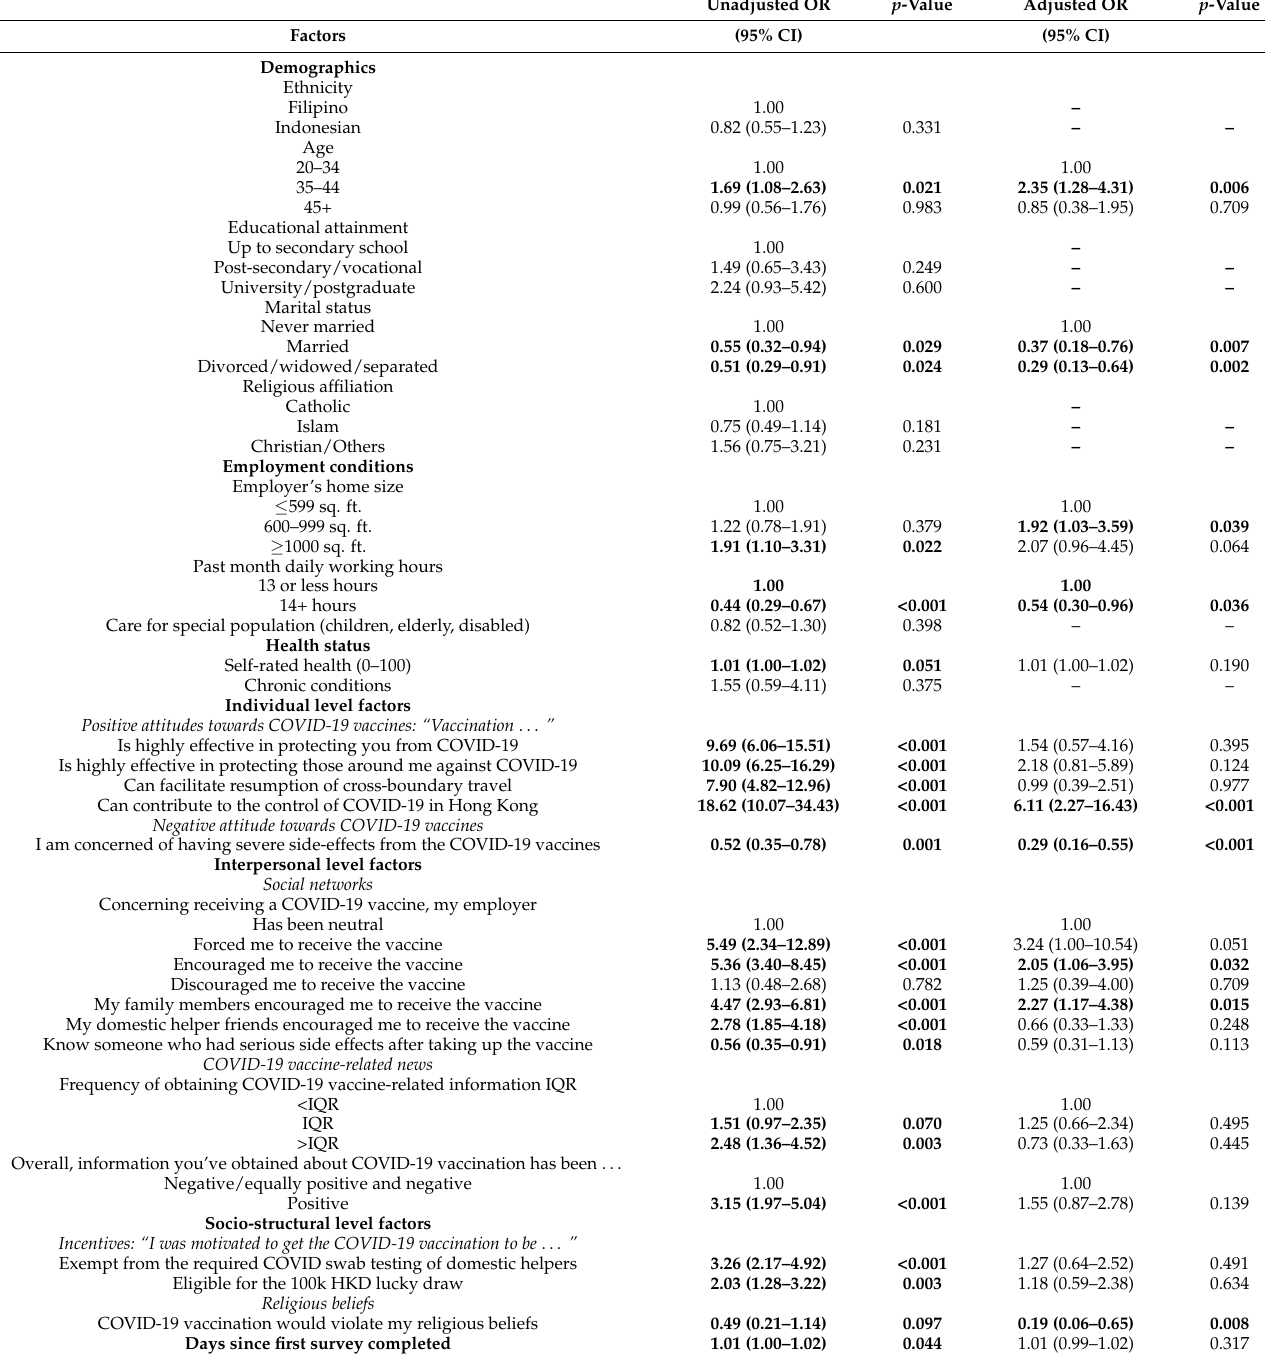
Table 4. Associations with vaccine uptake among female foreign domestic workers ( n =